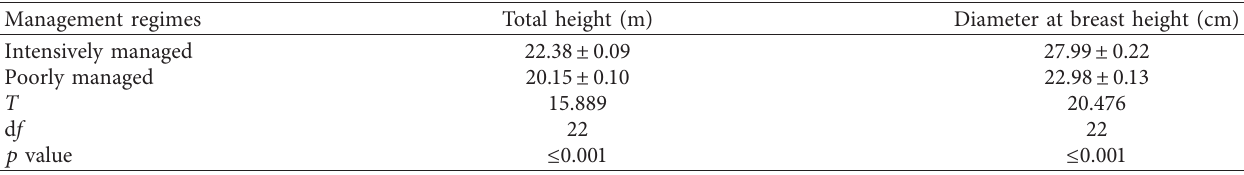
Table 6: Mean total height and diameter at breast height of Tectona grandis under intensive and poor management. Management regimes